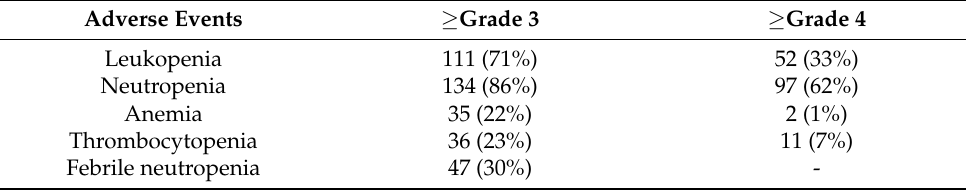
Table 2. Hematological toxicities ( N =